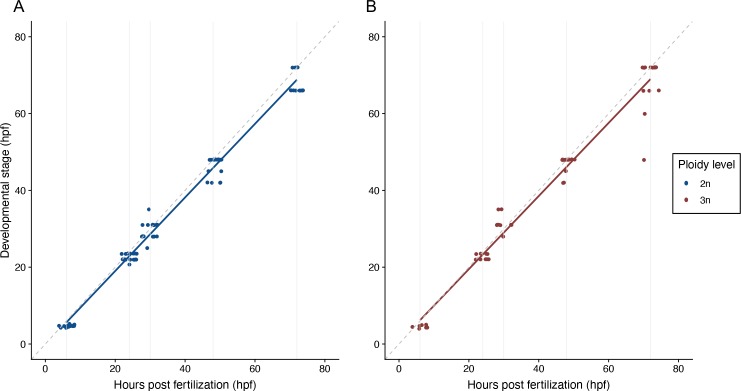
Development of diploid and triploid larvae up to 72 hpf.A) Development of diploid larvae, n = 82. B) Development of triploid larvae, n = 55. In both A) and B) the dashed grey line is the reference x = y. Solid grey lines are the hours post fertilization at which the embryos and larvae were staged, namely: 6, 24, 30, 48 and 72 hours. ANOVA, p = 0.47.